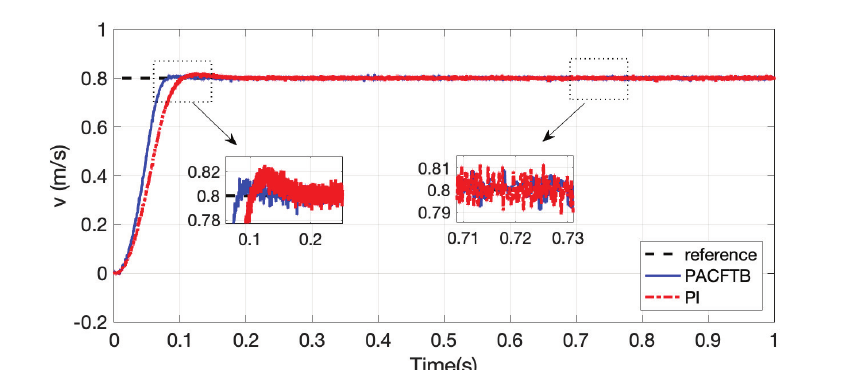
Figure 11. Speed tracking performance of LIM.